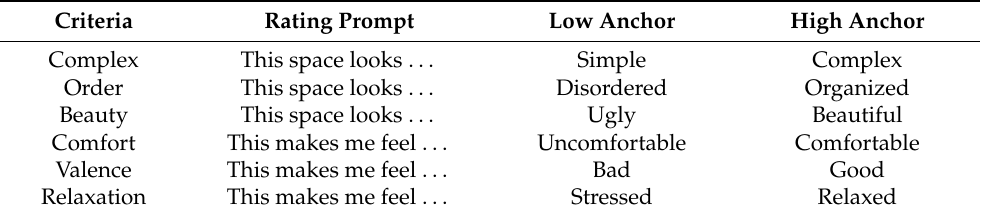
Table 1. Aesthetic rating criteria. Criteria Rating Prompt Low Anchor High Anchor Complex This space looks . . . Simple Complex Order This space looks . . . Disordered Organized